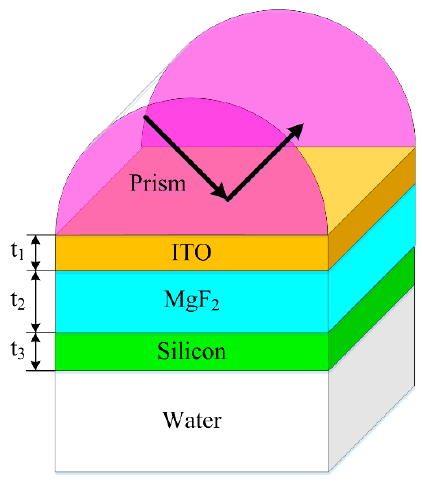
Figure 1. Schematic diagram of the SPR sensor.